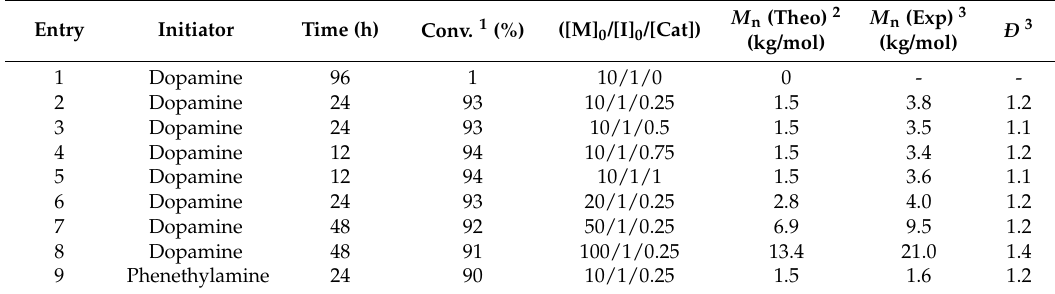
Table1 . Different synthesis routes for the polymerization L -lactide initiated by dopamine. Table 1. Different synthesis routes for the polymerization L -lactide initiated by